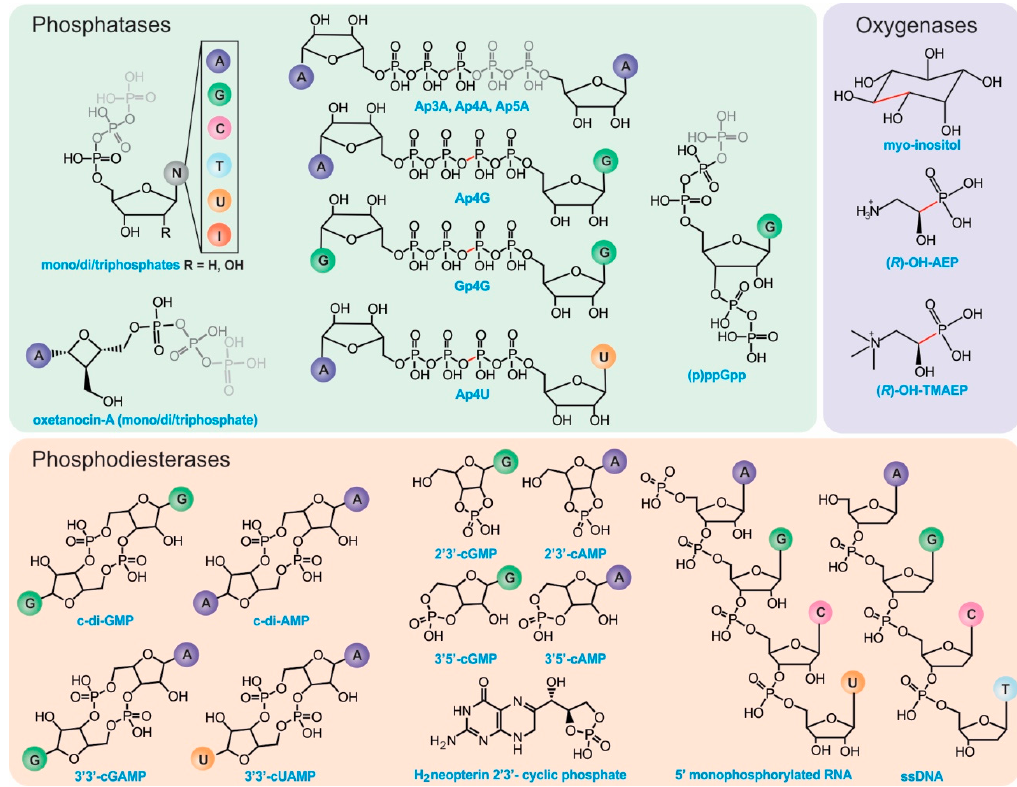
Figure 2. Known substrates of HD-domain proteins. Phosphatases can remove one to three terminal phosphate groups from (deoxy)ribonucleotides or cleave (a)symmetrically polyphosphate containing nucleotides (represented in gray). The position of cleavage has been highlighted in red for substrates with four phosphates. PDEs hydrolyze phosphodiester bonds of cyclic (di)nucleotide substrates via either one-step hydrolysis (cleavage of one side of the diester bond) releasing a linearized product or two-step hydrolysis releasing individual nucleotides. PDEs can also act on RNA and DNA substrates. HD-domain oxygenases oxidatively cleave a C-X bond (indicated in red).